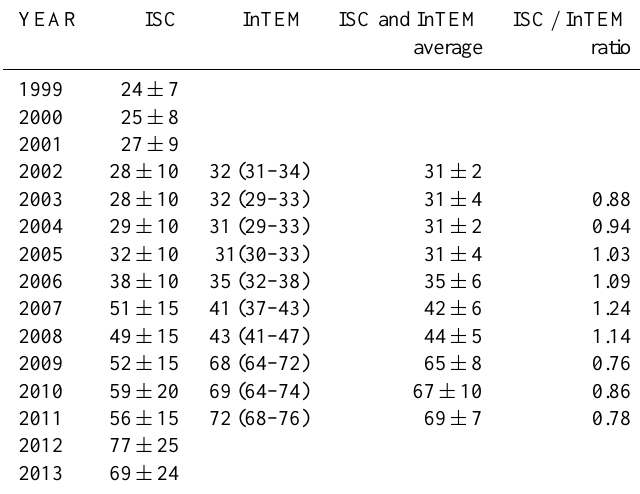
Table 4. Australian HFC-152a emissions (Mgyr − 1 , 3-year running averages) calculated from Cape Grim in situ observations via ISC (ADS and Medusa data, uncertainty: ± 1SD) and inverse modeling using InTEM (Medusa data, range: 25th–75th percentiles); ISC, NAME averages weighted by uncertainties, ISC InTEM average for 2004 is based only on InTEM